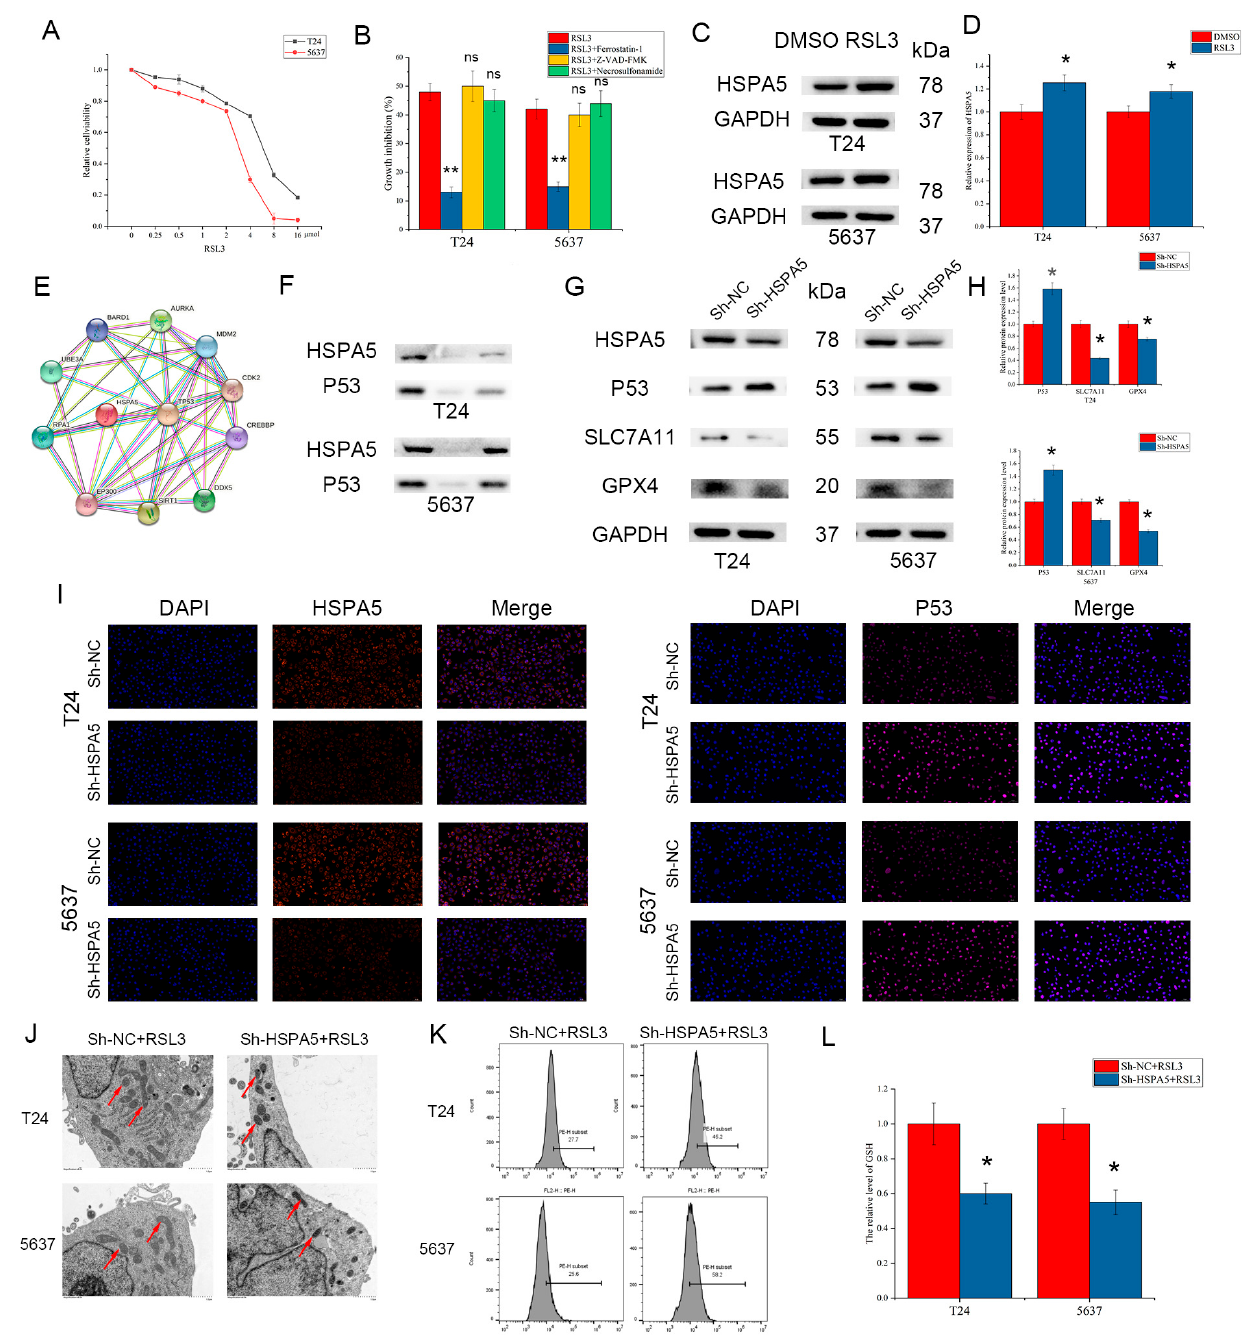
Figure 8. HSPA5 inhibition enhances BCa cell ferroptosis. ( A ) RSL3 (24 h) induced BCa cell ferroptosis in a concentration-dependent manner. ( B ) The inhibitory effects of T24 (5 μ mol, 24 h) and 5637 (3 μ mol, 24 h) could be decreased by the administration of the ferroptosis inhibitor ferrostatin-1 (2 μ mol, 24 h) but not the apoptosis inhibitor Z-VAD-FMK (10 μ mol, 24 h) or the necroptosis inhibitor necrosulfonamide (1 μ mol, 24 h). ( C , D ) The expression of HSPA5 after treatment with RSL3 (1 μ mol, 24 h). ( E ) STRING database (https://cn.string-db.org/) (accessed on 27 August 2022) and ( F ) CO-IP analyses revealed that HSPA5 interacted with P53. ( G – I ) HSPA5 could